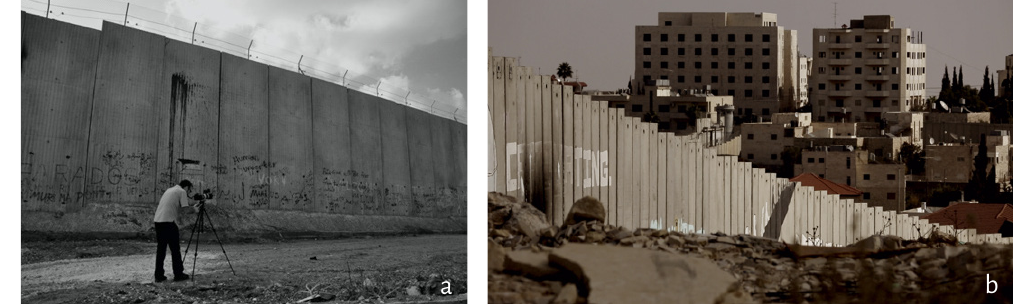
Fig. 1 Separation Wall (Israeli) or Apartheid Wall (Arabic), Bethlehem (a) Qalqylia (b). Photos by Martine